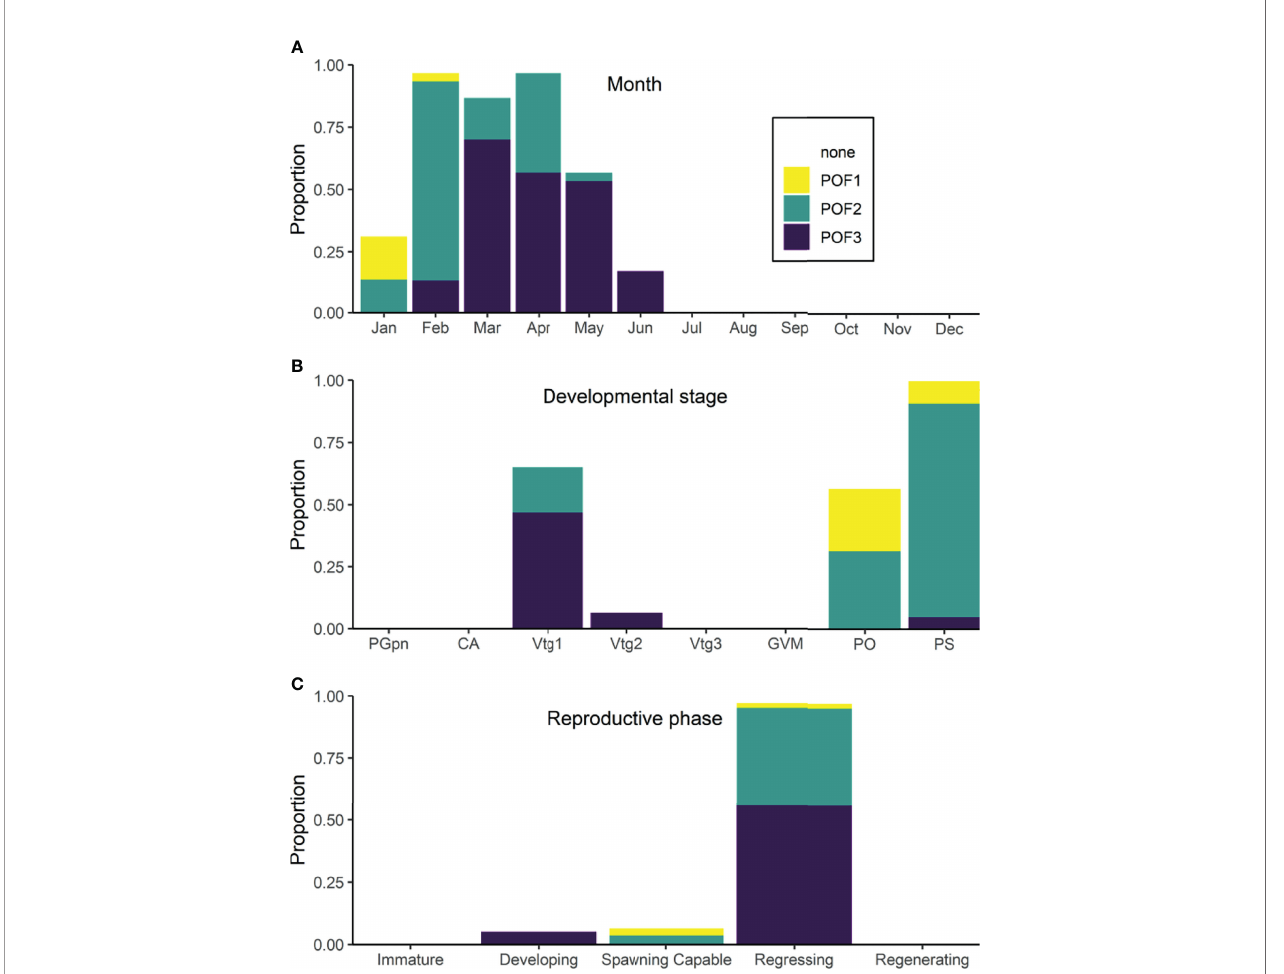
FIGURE 4 | Proportions and relative age of post-ovulatory follicles (POFs) in female Paci fi c halibut in months (A) , developmental stages (B) , and reproductive phases (C) where POF1 are ranked as the most recent, POF2 as older, and POF3 as the oldest